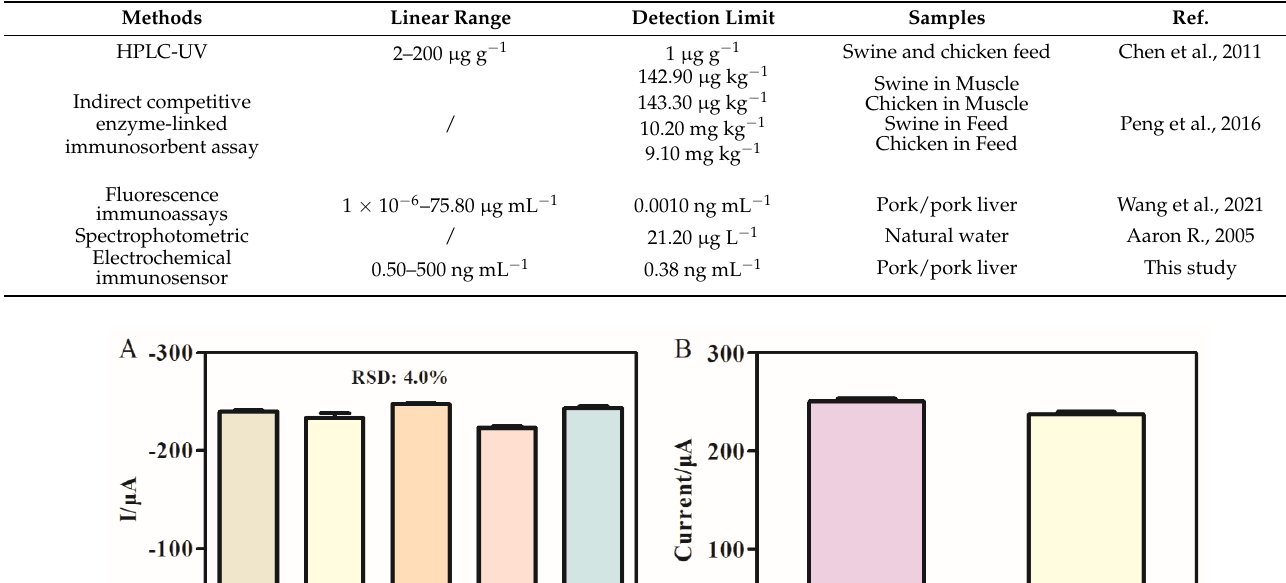
Table 1. Comparison of different analytical methods for determination of ASA.